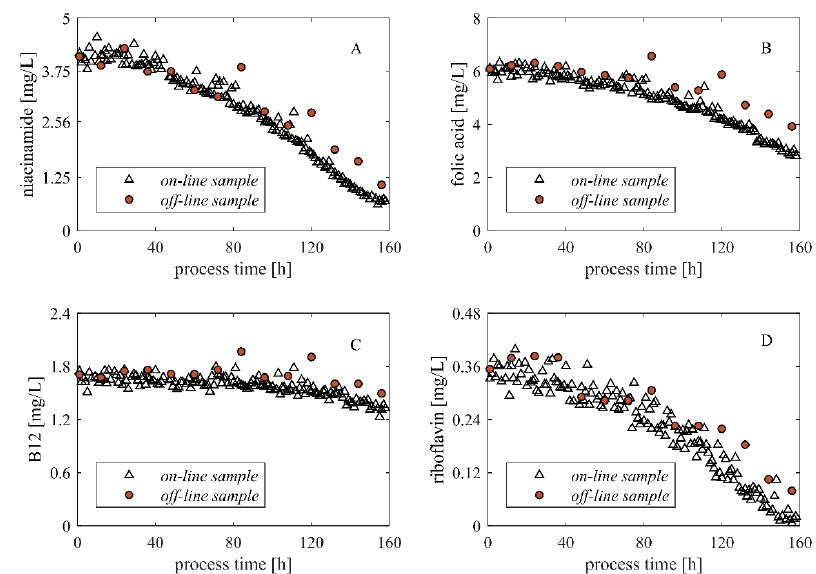
Figure A2. Vitamins were monitored on-line via HPLC. The plots display the concentrations over process time of four di ff erent vitamins, i.e., niacinamide in plot A, folic acid in plot B, B12 in plot C and riboflavin in plot D. On-line results (white triangles) and analytical results of manual samples measured off-line (red circles) are compared in each plot. The concentration ranges are very low; hence, high frequency on-line results support interpretation of metabolic behavior of the cells with regard to the analytes. Table A1. The automated sampling system Numera, especially the dilution module, was roughly evaluated for its impact on cell integrity. CHO cells cultivated in shake flasks were directly analyzed with a cell counter (Cedex ® HiRes, Roche Diagnostics, Germany) 5-fold. The same cell suspension was then processed with the Numera system, i.e., drawn from the shake flask, transferred via multiplexer and dilution module, and manually captured after the dilution step. Subsequently, the samples were analyzed with the cell counter. The procedure with Numera was performed two times and each captured sample was analyzed in duplicate. The sample was analyzed for viable cell count (VCC), total cell count (TCC), viability, and cell debris. The results showed no noticeable impact of the Numera system on cell integrity. Sample